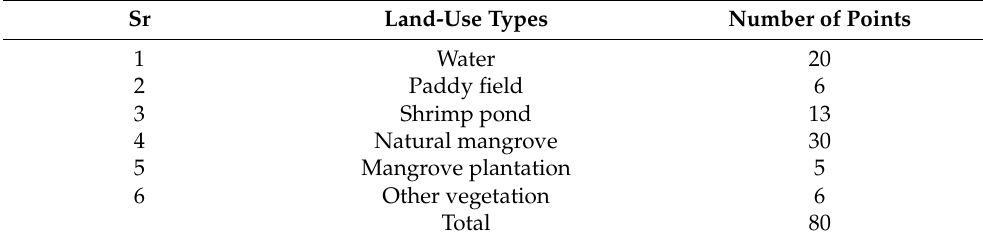
Figure 1. Location of the study area, ( a ) Wunbaik Mangrove Forest (Sentinel-2 true color image), ( b ) Rakhine coastal region in Myanmar. Table 1. Ground location points of different land uses in the study